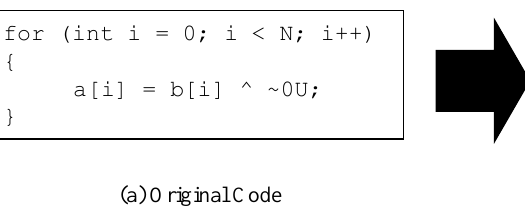
Figure 4. Code comparison between original and loop unrolling